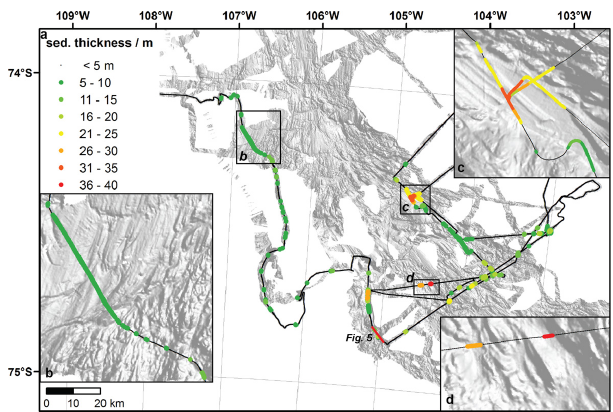
Fig. 4. (a) Sediment thickness (coloured dots) derived from PARA- SOUND data, modified from Rackebrandt (2006). Black line indicates segments of R/V Polarstern ANT-XXIII/4 ship track where no significant sediment thickness was identified. Multibeam bathymetry data with artificial sun-illumination are shown as back- ground. Details in insets (b) , (c) , and (d) show that thicker sediment deposits occur mainly in channels, but not in every channel. Loca- tion of Fig. 5 is marked by red